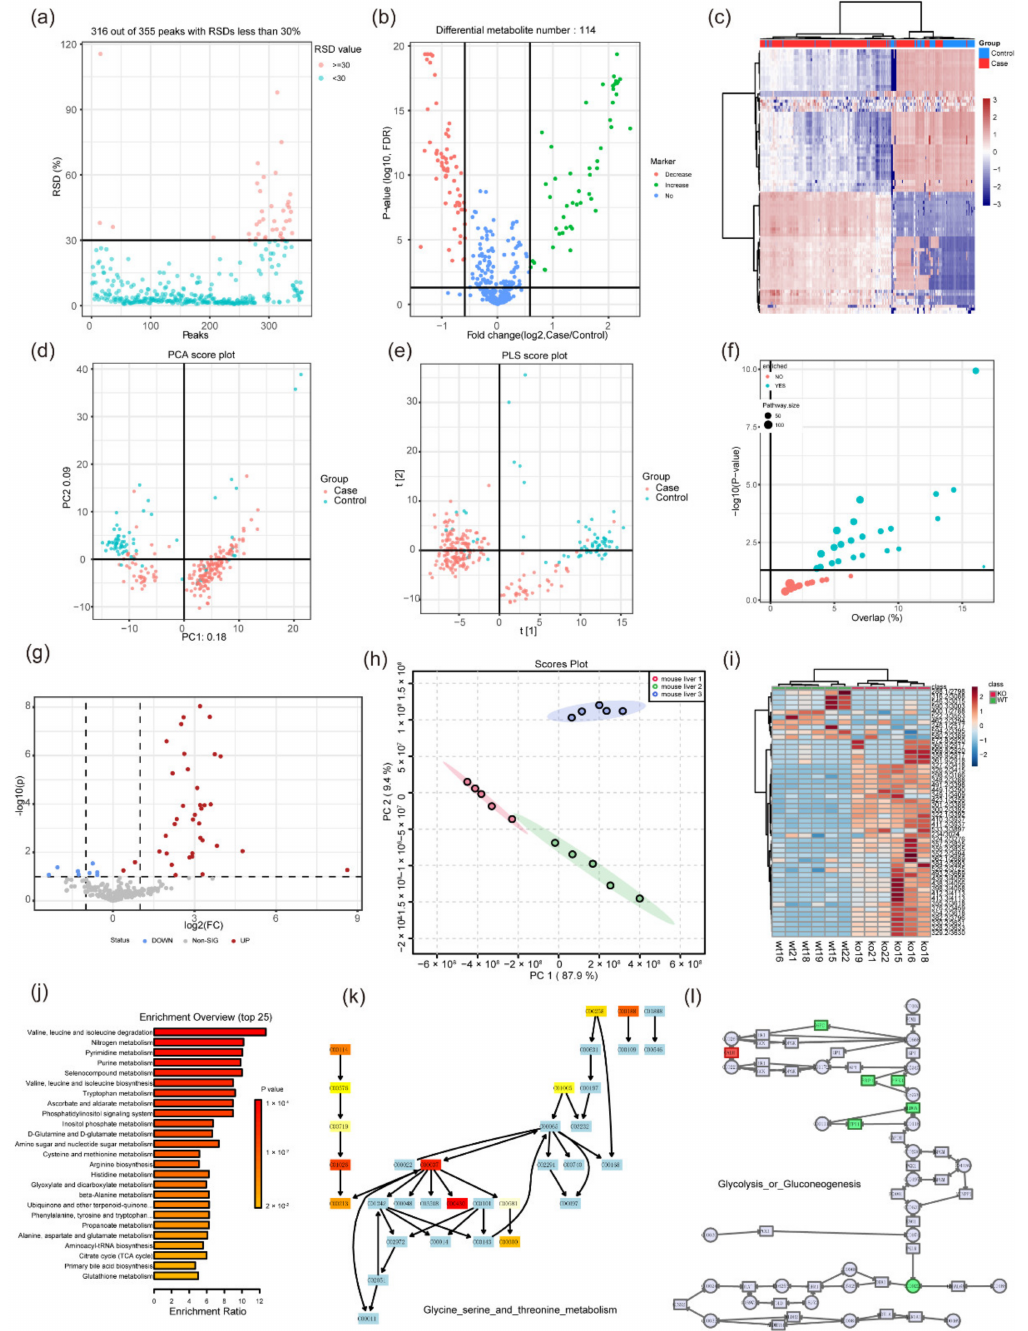
Figure 2. Some graphical visualization features of MetFlow and MetaboAnalyst 5.0. ( a ) RSD (relative standard deviation) plot in the data processing function of MetFlow. Features with a high percent RSD should be removed from the subsequent analysis (the suggested threshold is 20% for LC-MS and 30% for GC-MS). ( b ) Volcano plot and ( c ) heatmap of the differential metabolites in the statistical analysis function of MetFlow, the thresholds can be set autonomously by the submitter. ( d ) PCA analysis and ( e ) PLS analysis in MetFlow. ( f ) Pathway enrichment overview in MetFlow, each circle represents a different pathway. Circle size and color are based on the pathway size and p -value. ( g ) Volcano plot of the differential analysis in MetaboAnalyst 5.0. ( h ) PCA analysis plot in MetaboAnalyst 5.0. ( i ) Heatmap shows the differential metabolites in the statistical analysis function of MetaboAnalyst 5.0. ( j ) Pathway enrichment overview in MetaboAnalyst 5.0. Color shade is based on the p -value. ( k ) The demo-enriched metabolism pathway in MetaboAnalyst 5.0. Light